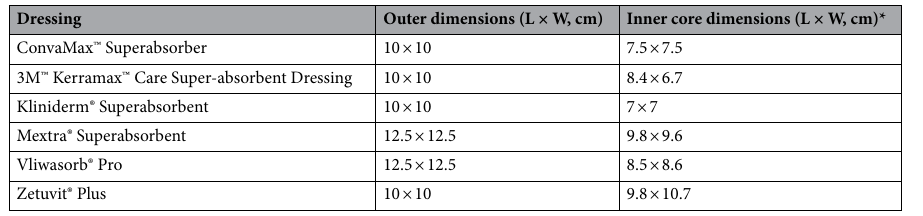
Table 1. Summary of superabsorbent dressing specifications. * As determined by